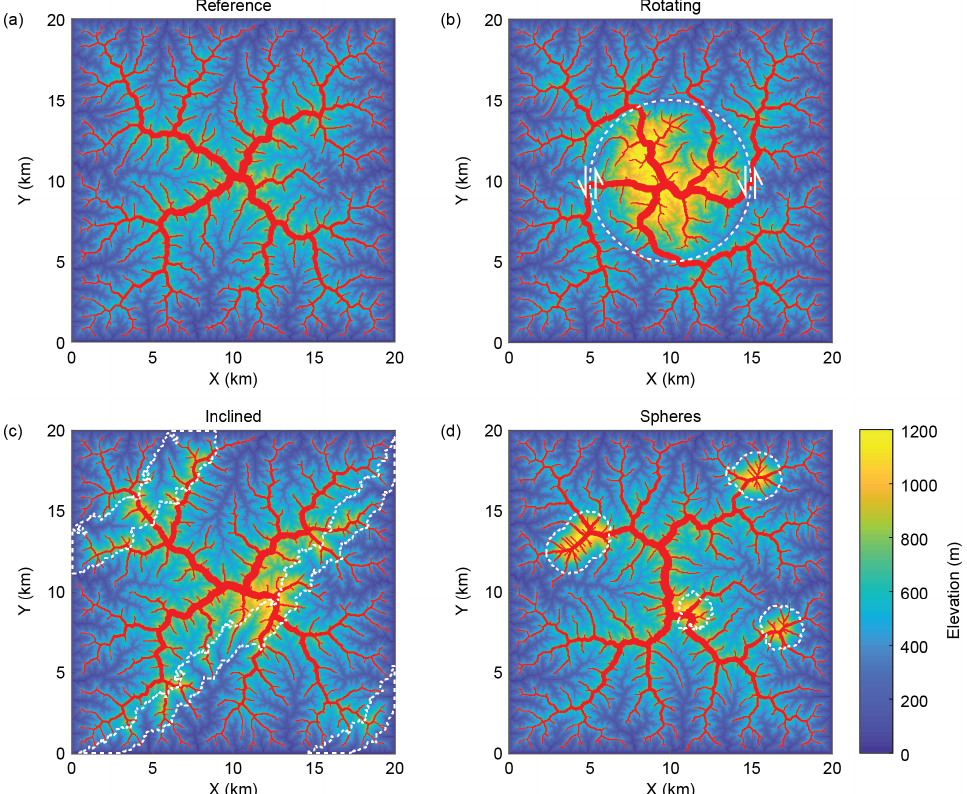
Figure 4. Modeled topography and drainage divide network (red solid lines) at the end of the landscape evolution experiments: (a) Reference, (b) Rotating, (c) Inclined, and (d) Spheres. White stippled lines show strike-slip fault in panel (b) and regions with reduced erodibility in panels (c) and (d)